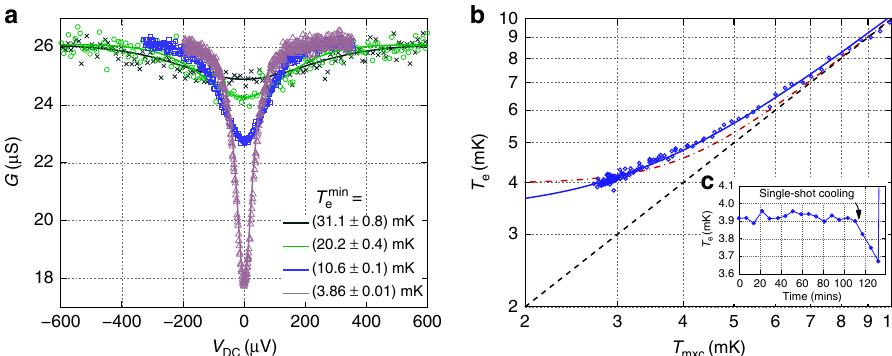
Figure 4 | Characteristics of a CBT immersed in 3 He/ 4 He refrigerant. ( a ) Fitting to the warmest three measurements gives C S ¼ 209.5 fF and for the warmest three curves are in reasonable agreement with the refrigerator temperatures R T ¼ 23.21k O . The fitted minimum electron temperatures T min e as measured by the vibrating wire resonator (VWR) thermometer: 29.4, 19.0 and 10.5mK, respectively. ( b ) Measured electron temperature in the CBTas T x c , yielding an exponent x ¼ 2.7. the refrigerator cooled steadily from 10 to 2.7mK over a period of 12h. The solid curve shows a fit of the form T x e ¼ mxc þ T 5 c . The dashed line shows T e ¼ T mxc . ( c ) The measured T e as the refrigerator was temporarily cooled in The dot-dashed curve shows a best fit of T 5 e ¼ mxc þ single-shot mode to 2.2mK, reaching a lowest T e below